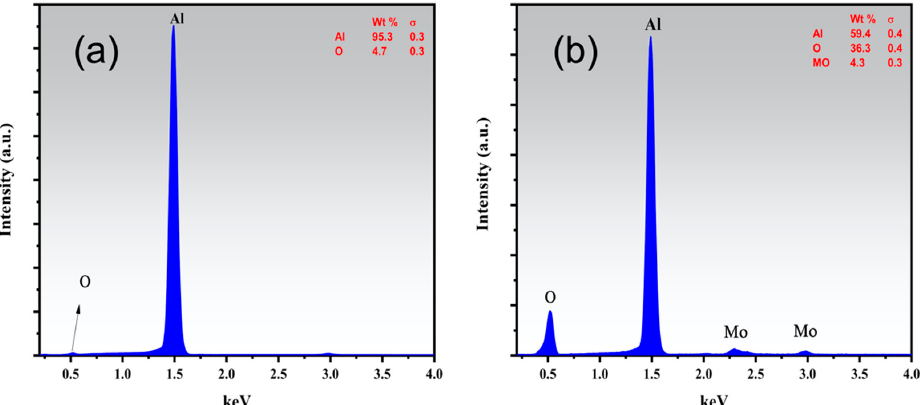
Figure 5. EDS spectra of ( a ) pristine Al 6061 and ( b ) MoO (x) -coated structured Al 6061. The O content is around 5 wt% in the pristine sample. The coated sample shows Mo presence as well as an enhanced O content of over 30 wt%.